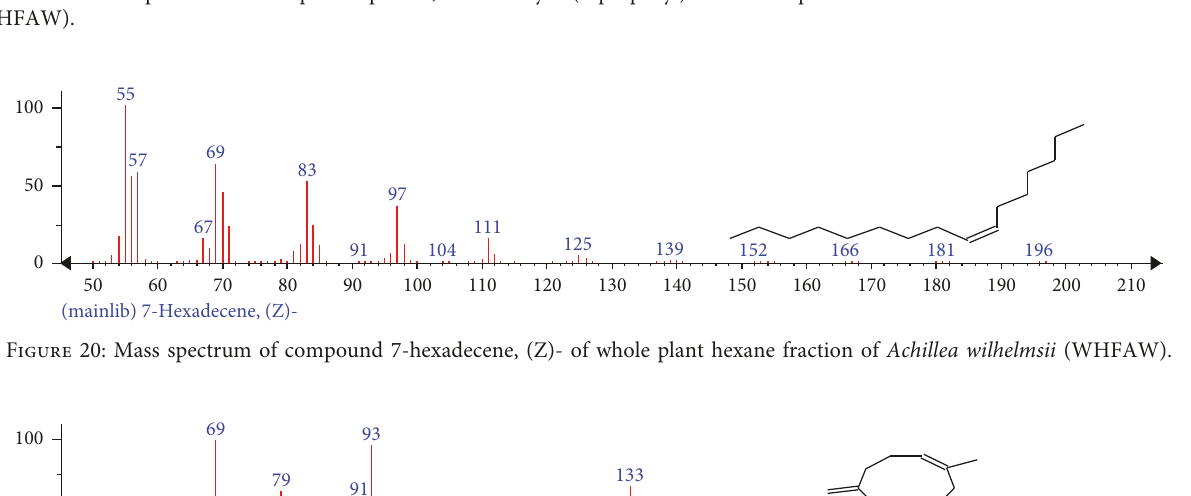
Figure 19: Mass spectrum of compound phenol, 2-methoxy-3-(2-propenyl)- of whole plant hexane fraction of Achillea wilhelmsii